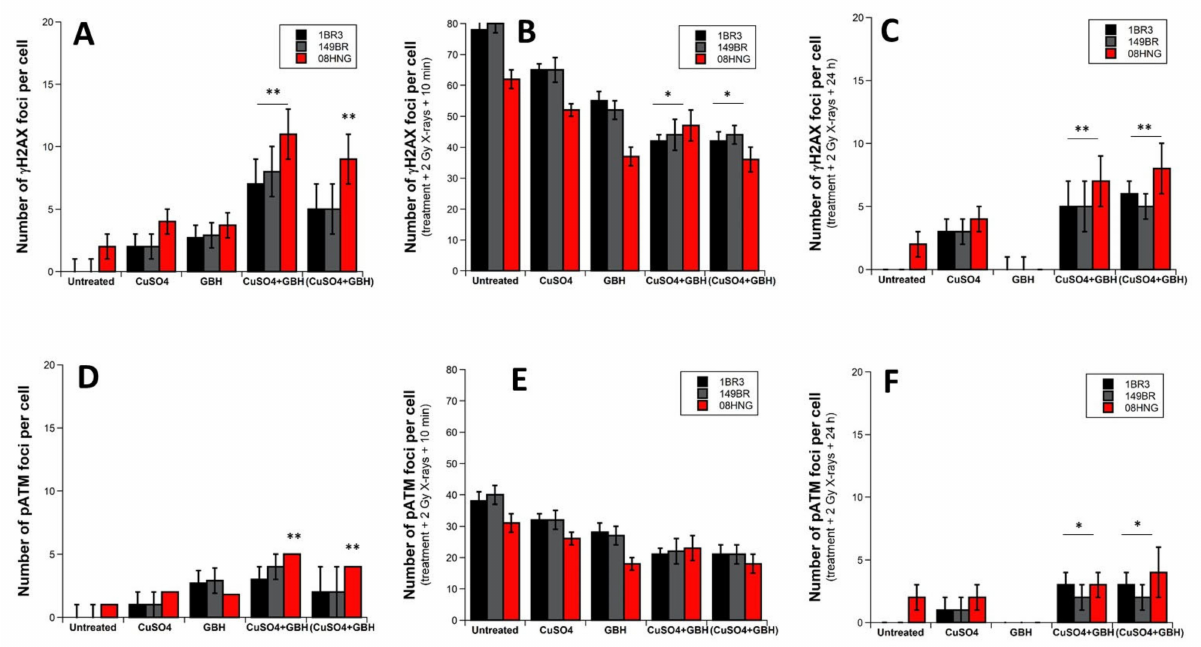
Figure 8. γ H2AX and pATM foci from fibroblasts exposed to CuSO 4 and/or GBH. Indicated cells were exposed to 24 h incubation with the indicated metal, pesticide, CuSO 4 + GBH or 99% purified (CuSO 4 +GBH) complexes solutions, then irradiated at 2 Gy X-rays and incubated up to 24 h for repair. “Untreated” mention means that neither pesticide nor metal were applied to cells before irradiation. The numbers of γ H2AX and pATM foci per cell were assessed before irradiation ( A , D ), at 10 min post-irradiation ( B , E ), and at 24 h post-irradiation ( C , F ), respectively. Each plot represents the mean ± standard error (SEM) of 3 replicates. One or two asterisks represent significant differences from GBH data with p < 0.05, p < 0.01,